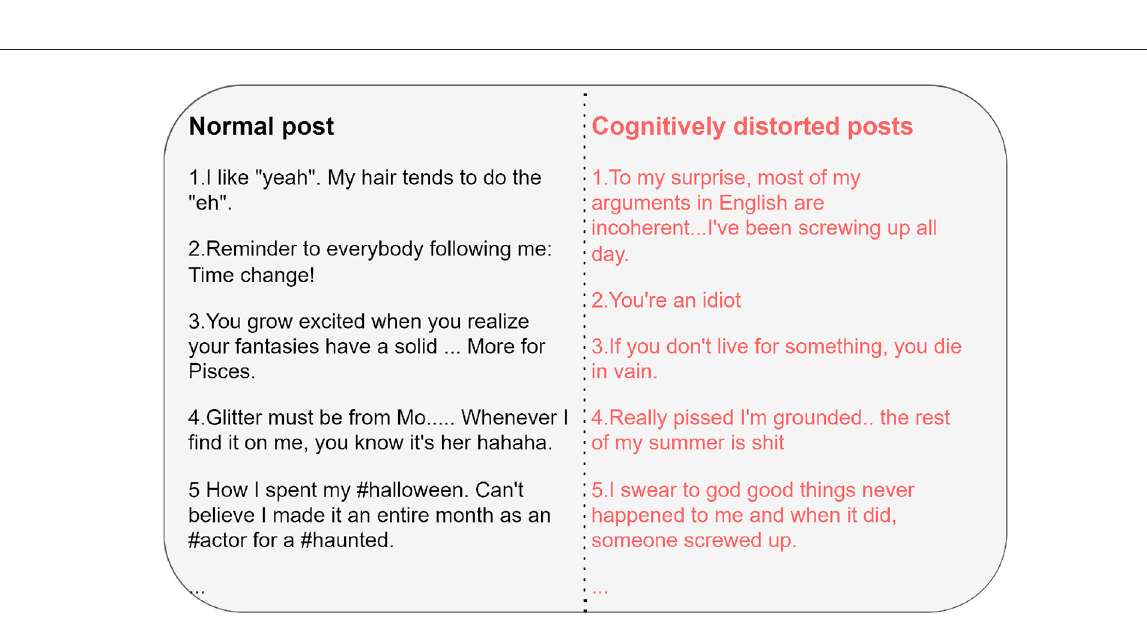
FIGURE7 This figure shows the difference between cognitively distorted extracted text and regular text. Professionals can use the text processed by the model to examine the psychological situation of users and treat